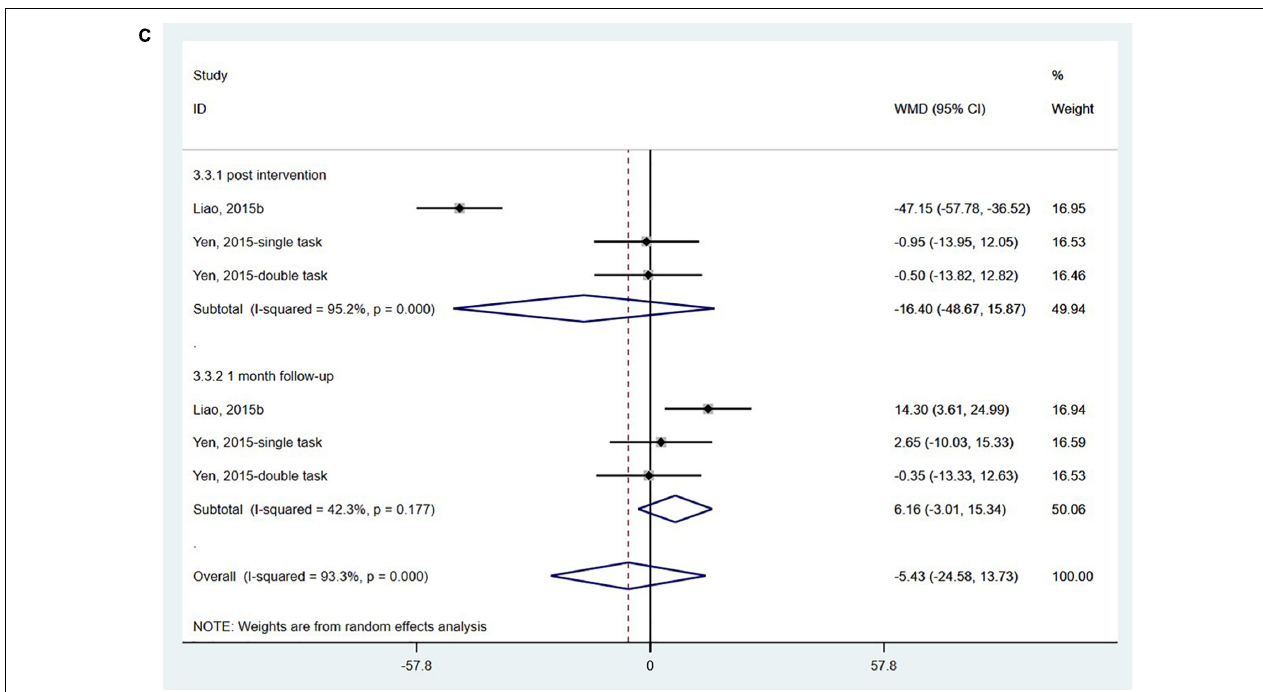
FIGURE 3 | Forest plot of pooled results for sensory organization test. (A) Somatosensory scores. (B) Visual scores. (C) Vestibular scores.